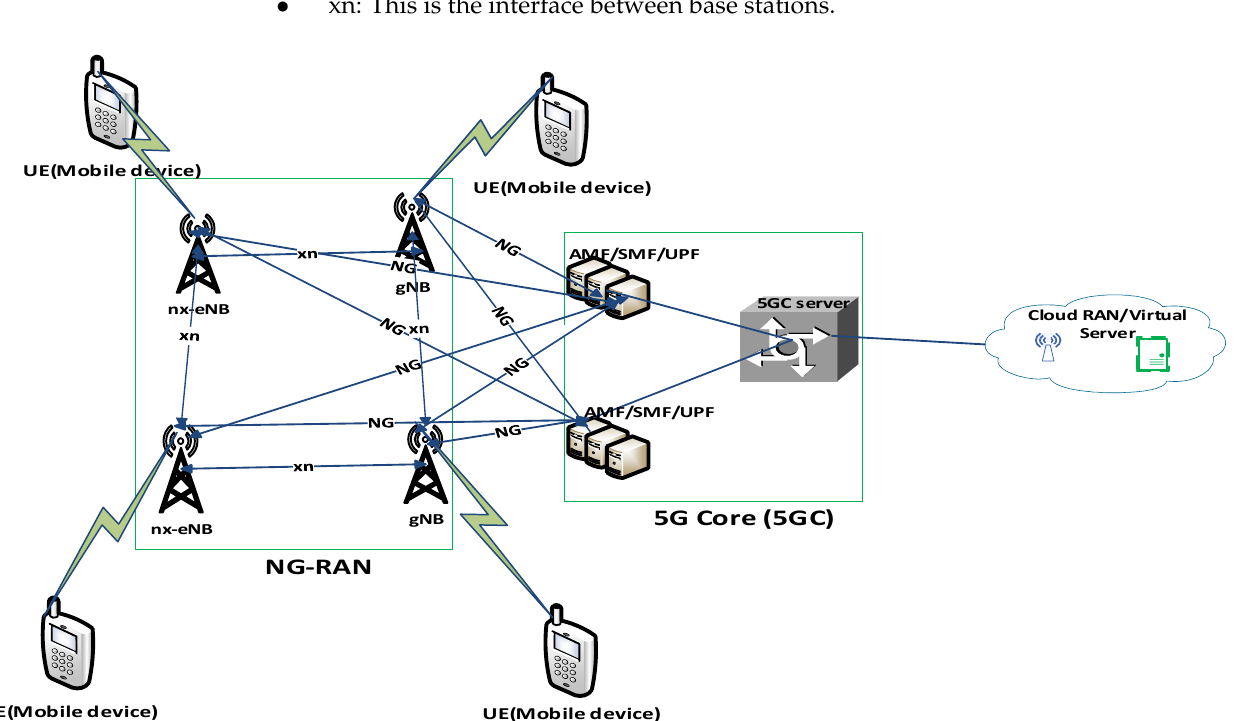
Figure 1. 5G Network